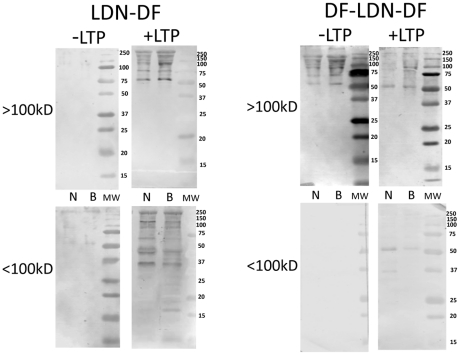
Western/far-Western blot analyses of (Fucα1,2/Fucα1,3)-linked LDN glycotopes on plasma proteins.Fractionated NMRI (N) and BS-90 (B) Biomphalaria glabrata plasma (>100 kDa; <100 kDa) were probed with schistosome glycan-specific mABs recognizing LacdiNAc (LDN) containing one or two α1,2-linked fucosyl-dimers (LDN-DF; DF-LDN-DF; see Table 1 for structures and mAB used). Blotted plasma proteins were incubated in the presence (+LTP) or absence (−LTP) of S. mansoni larval transformation products (LTP) prior to mAB treatment to determine the effects of LTP exposure on the distribution and intensity of these glycotopes among plasma proteins. Molecular weight markers are indicated on the right.